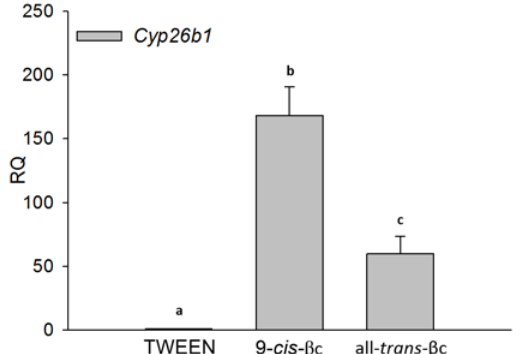
Figure 2. 9- cis - βc induced macrophage cytochrome P450 26B1 (CYP26B1) expression. RAW264.7 macrophage cells were treated for 24 h with vehicle (TWEEN 40), 2 µM of 9- cis - βc or all - trans - βc. The expression of CYP26B1 mRNA was measured by quantitate real-time PCR assays (TaqMan) standardized against GAPDH mRNA levels. The results are expressed as mean ± SE. of six independent experiments. Different letters represent significant differences between treatments, p < 0.05.